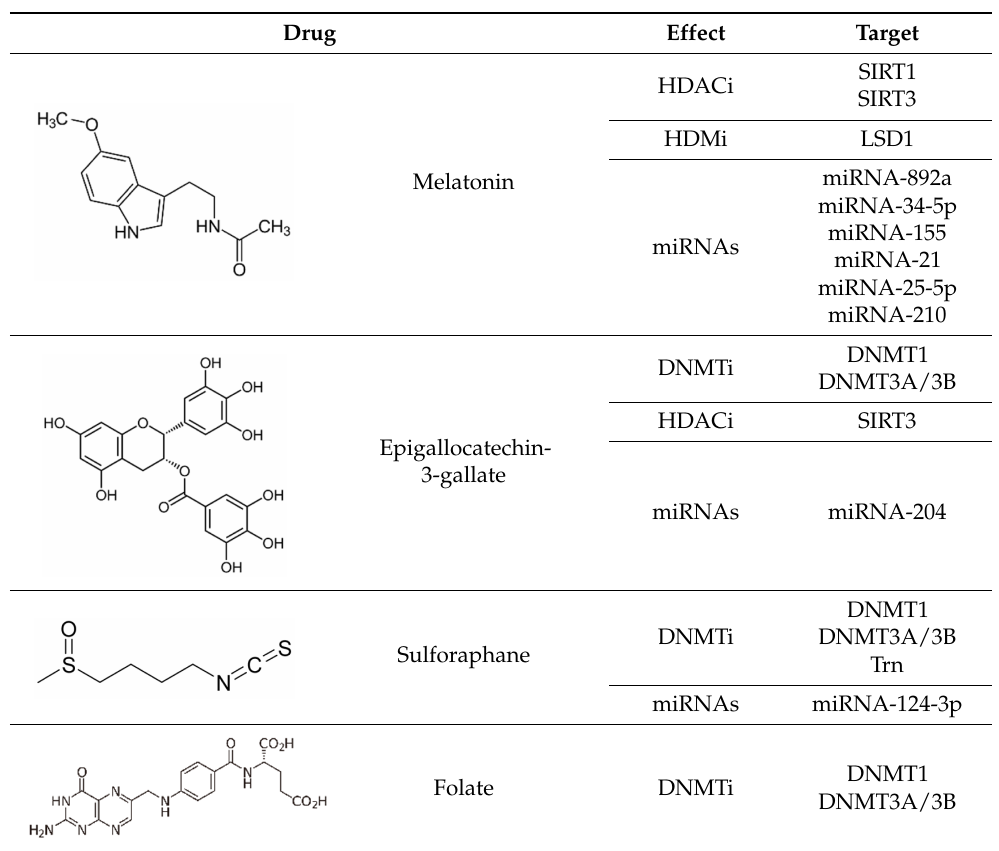
Table 1 summarizes the epigenetic effects of the antioxidants reviewed in this article. Table 1. Epigenetic effects of antioxidants in the treatment of HNSCC [7,40,64,84–88,92,93,99,101,104, 1.